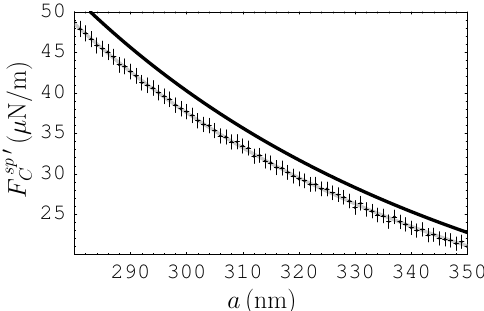
Figure 2. The mean measured gradients of the Casimir force between a Ni-coated sphere and a Ni-coated plate are shown by crosses as a function of separations. The top and bottom lines demonstrate theoretical predictions of the Lifshitz theory obtained with inclusion and neglect of the relaxation of conduction electrons,